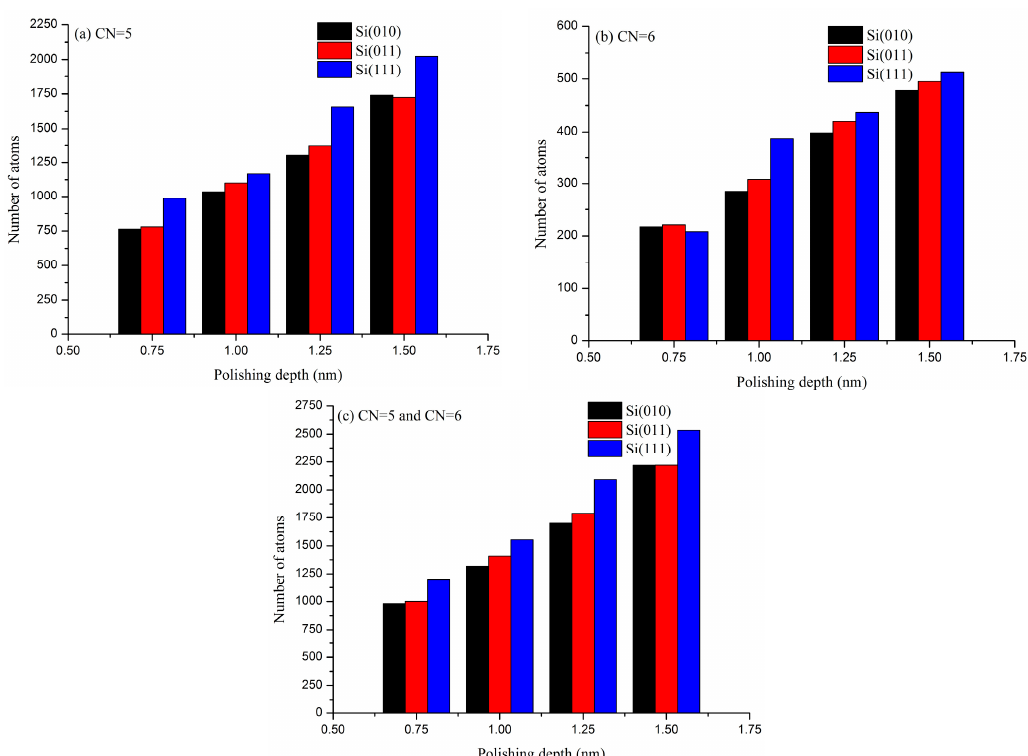
Figure 10. E ff ects of anisotropy on the number of atoms with coordination numbers 5 and 6 at di ff erent Figure 10. Effects of anisotropy on the number of atoms with coordination numbers 5 and 6 at polishing different polishing depths.